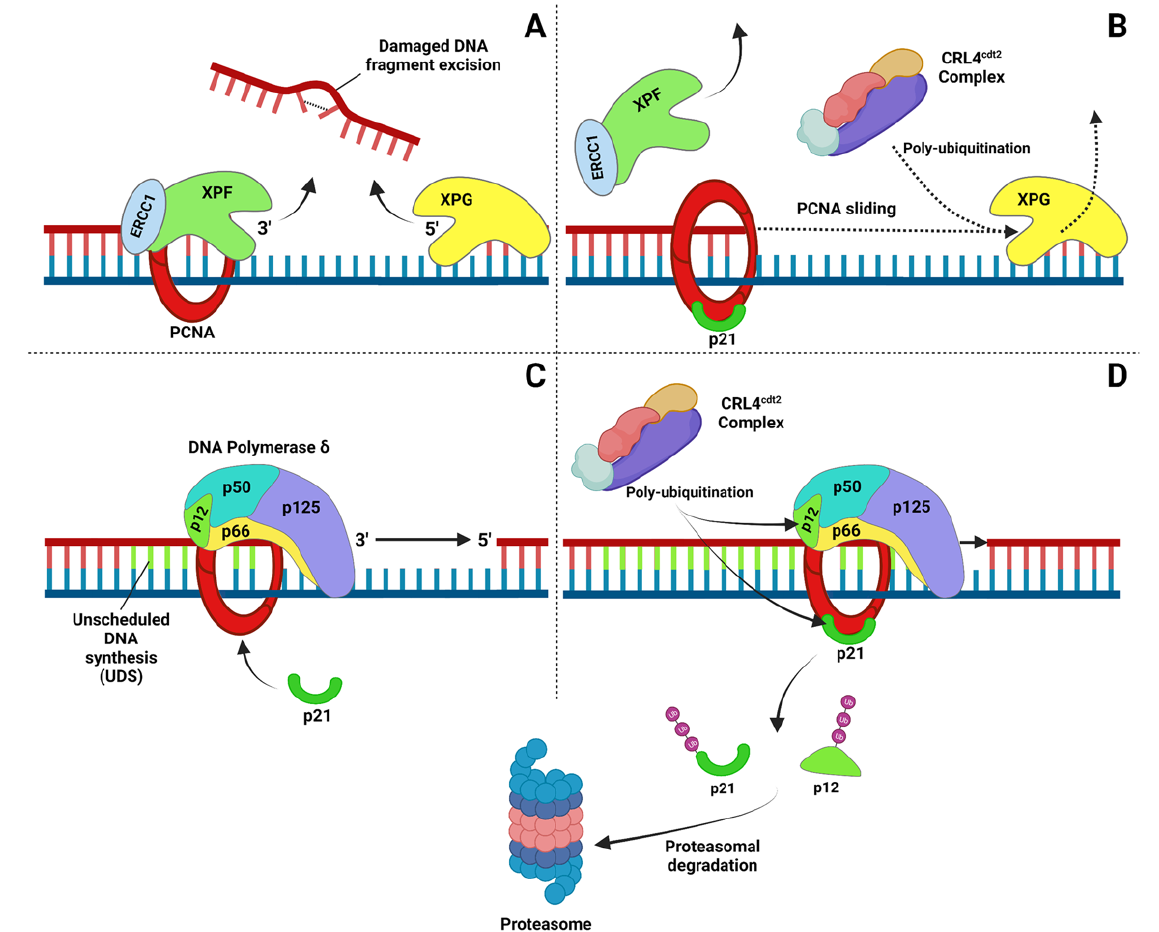
Figure 3. Schematic representation of p21 function during DNA repair. The example shown here is pertaining to NER, but it could be applied to other repair mechanisms where PCNA is involved.